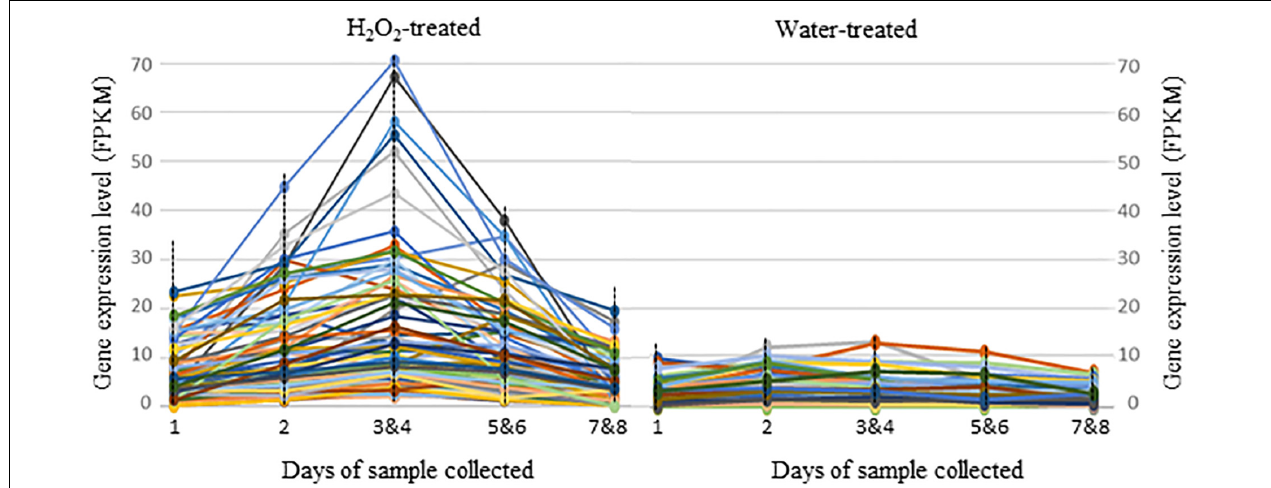
FIGURE 2 | Expression level changes for the 90 DEGs (differentially expressed genes) that were more highly expressed in seeds of sugarbeet lines F1004 and F1015 under H